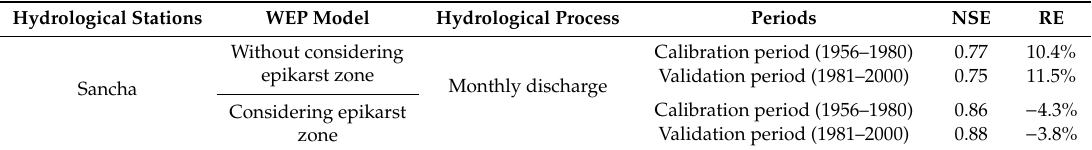
Table 3. Improved performance of the WEP-karst model at Sancha station in the Longjiang River basin. Hydrological Stations WEP